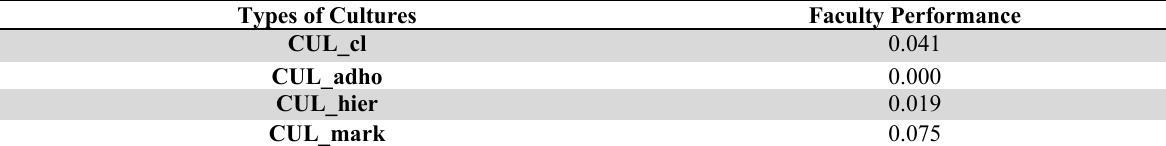
Effect Size ( f 2 ) of Types of Organizational Culture Types of Cultures Faculty Performance